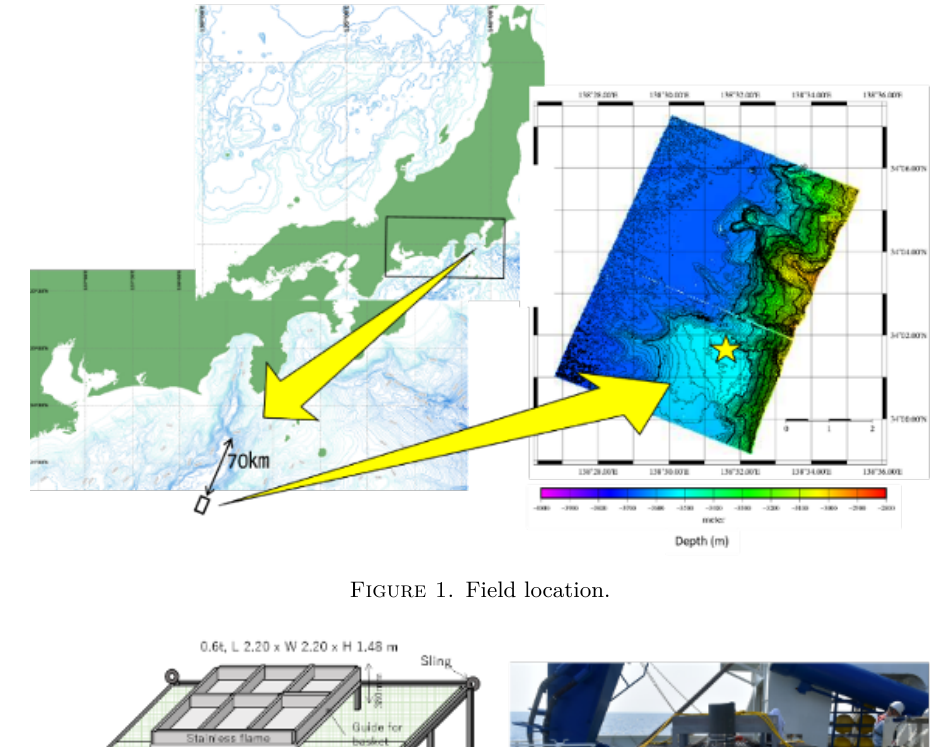
Figure 1. Field location.